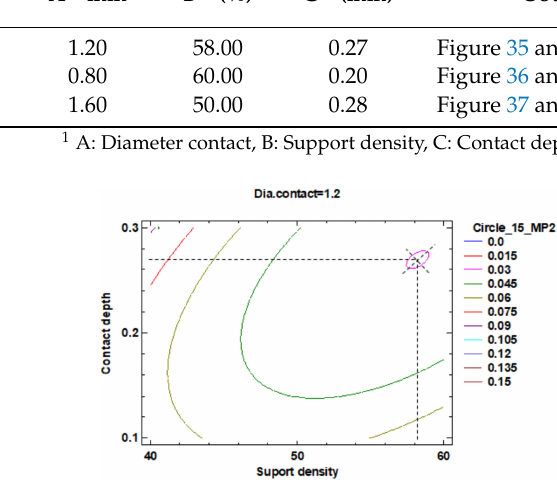
Figure 35. ContoursofEstimatedResponseSurfaceforRoundnessCircle_15_2andcentrediametercontact.